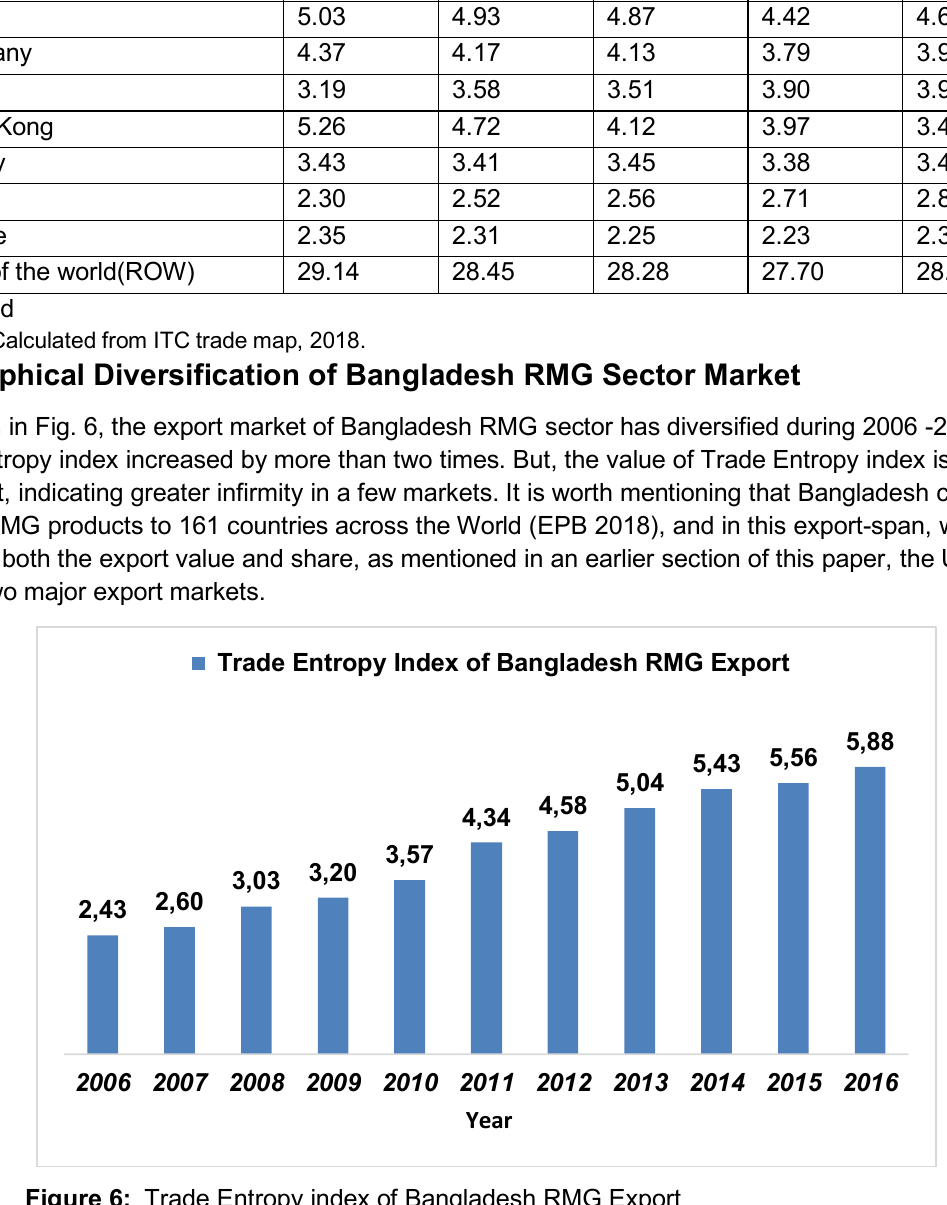
Figure 6: Trade Entropy index of Bangladesh RMG Export Source : Calculated from ITC data,